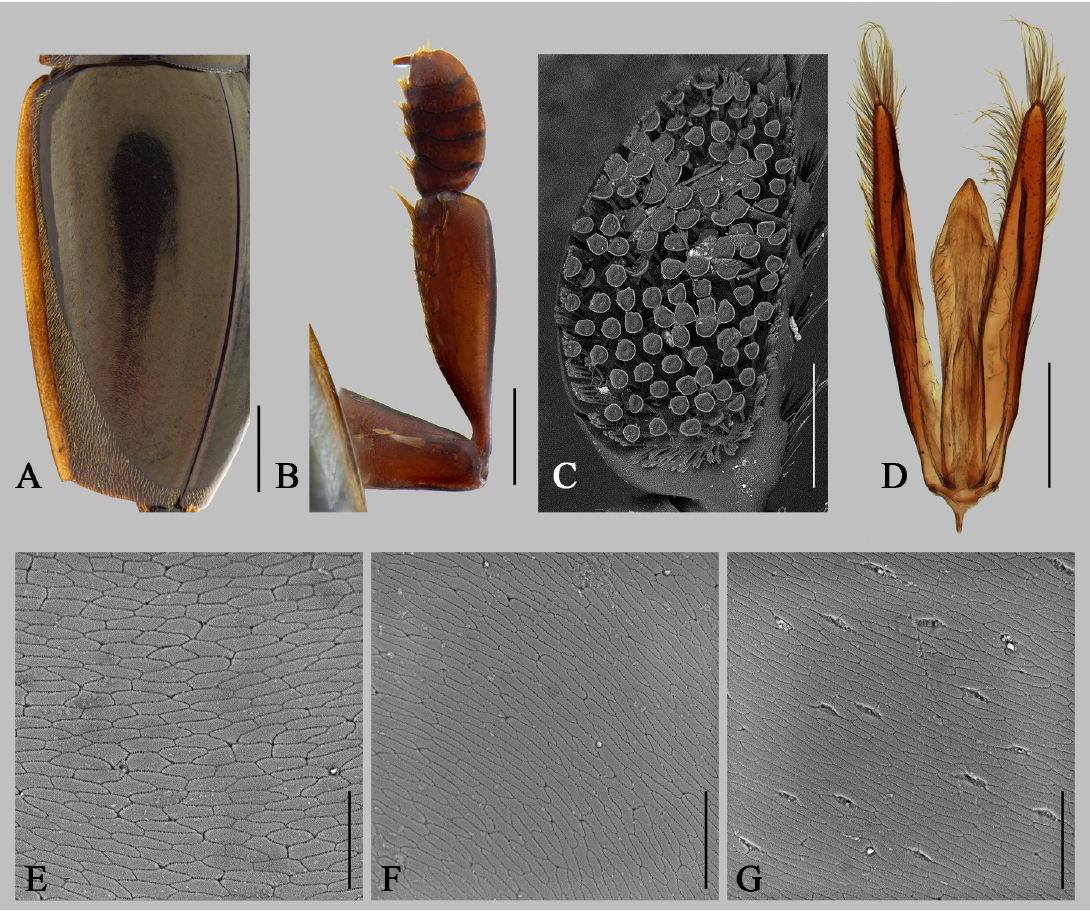
Fig. 3. Patrus hainanensis sp. nov., ♂ (SYSU). A . Left elytron, paratype. B . Front leg., paratype C . Front tarsus, paratype. D . Genitalia, holotype. E . Surface sculpture on head, paratype. F . Surface sculpture on pronotum, paratype. G . Surface sculpture on elytra, paratype. Scale bars: A = 1 mm; B, D = 0.5 mm; C = 200 μm; E–G = 30